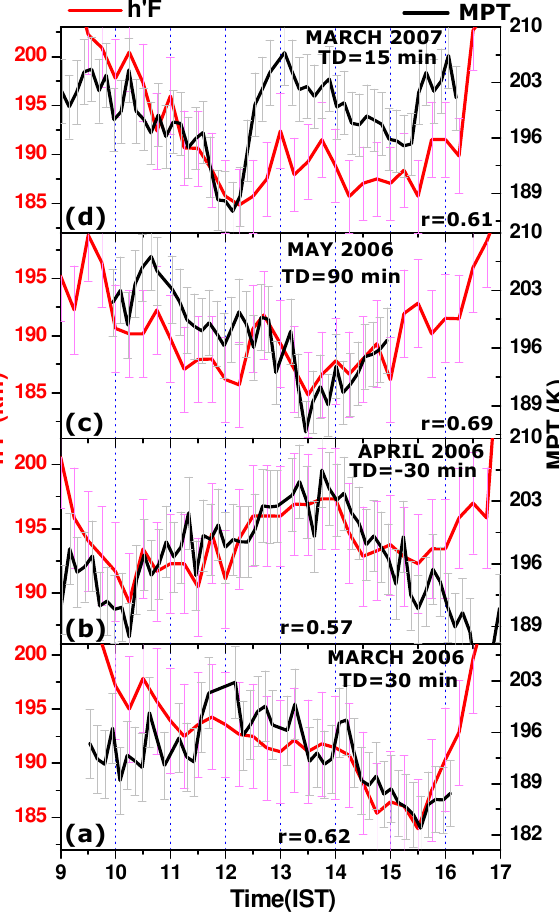
Fig. 1. Time variation of monthly mean h 0 F variations and time delayed equatorial mesopause temperature (MPT) along with their standard deviations (SD) for different months during the years 2005–2006. The corresponding time delays (TD) and correlation coefficients ( r ) are also shown in each panel.